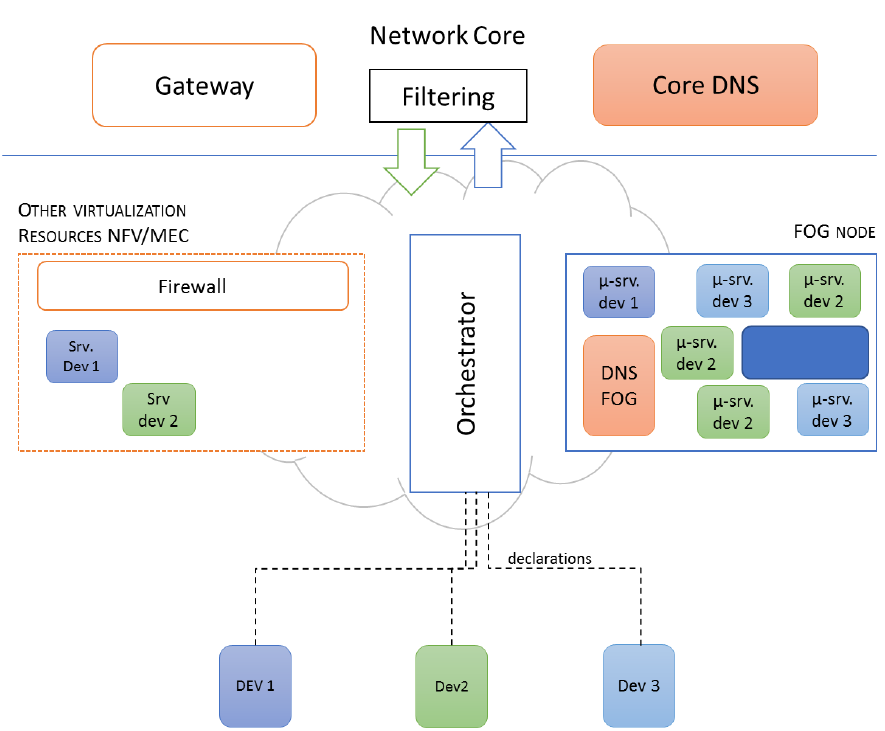
Figure 2. DNSFog as a microservice in a node filtered and firewalled from the core of the network.